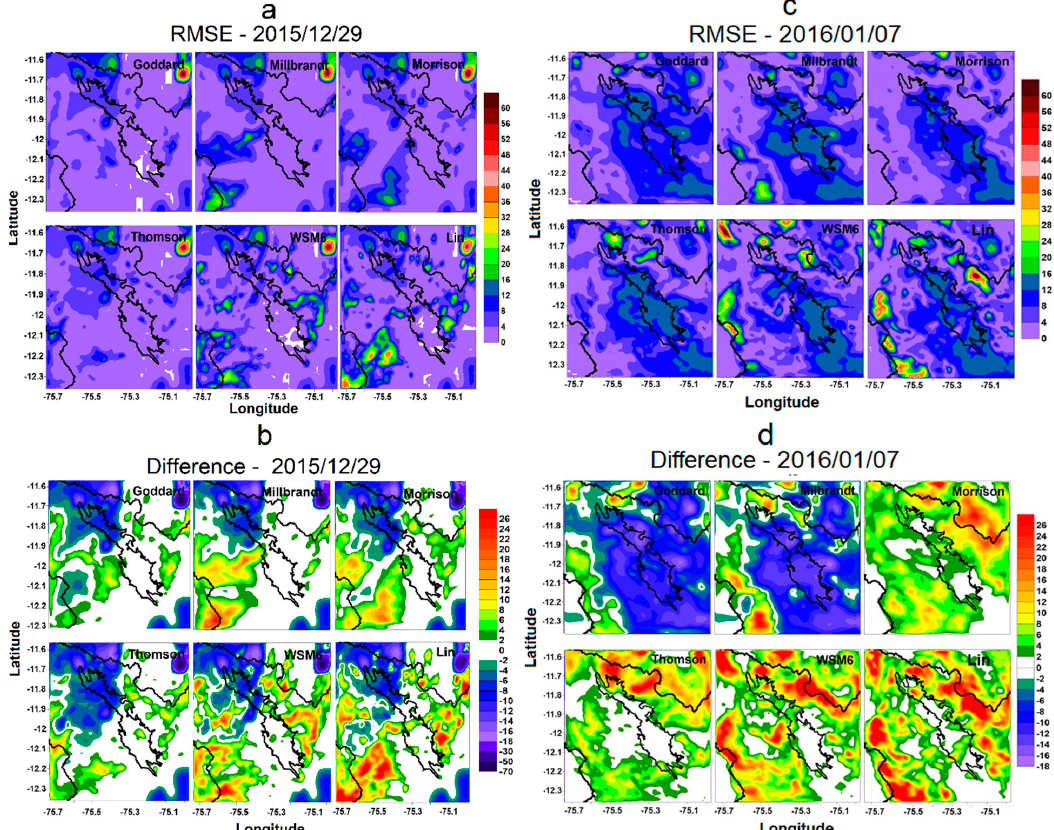
gauge observations (red dotted lines) and simulated rainfall (continuous colored lines) for CRE1. ( b ). Same as a, for CRE2.